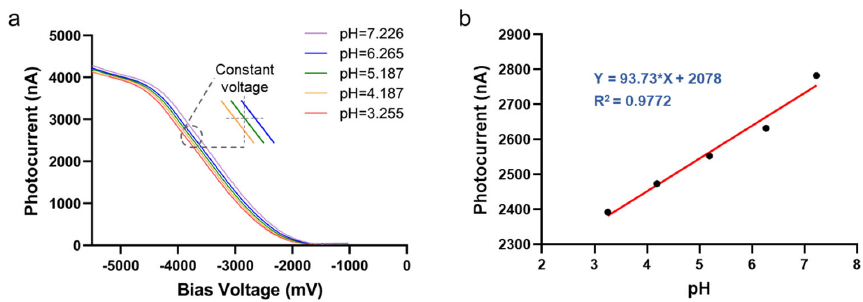
Figure 4. Performance evaluation of sensor unit. ( a ) I–V curves in different gradient pH solutions. ( b ) Sensor calibration curve in constant voltage mode (U = − 3760 mV).